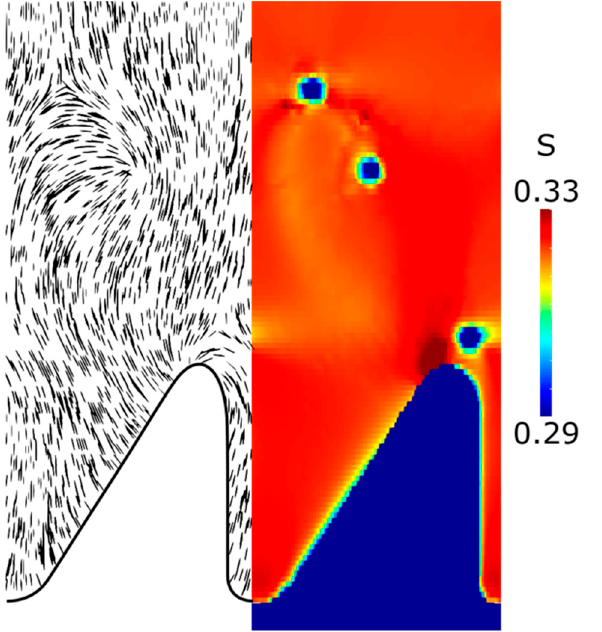
Figure 12. Modelling data of the continuous to defect latch highlighting the region near the grating during nucleation of a second latching defect pair. The average director orientations are shown on the left, and the simulated order parameter is given as a colourmap on the right. The scale for order parameter in the plot is shown to the right. The original defect pair are seen in the bulk near the top of the images and the second-generation pair are newly separated near the grating surface.